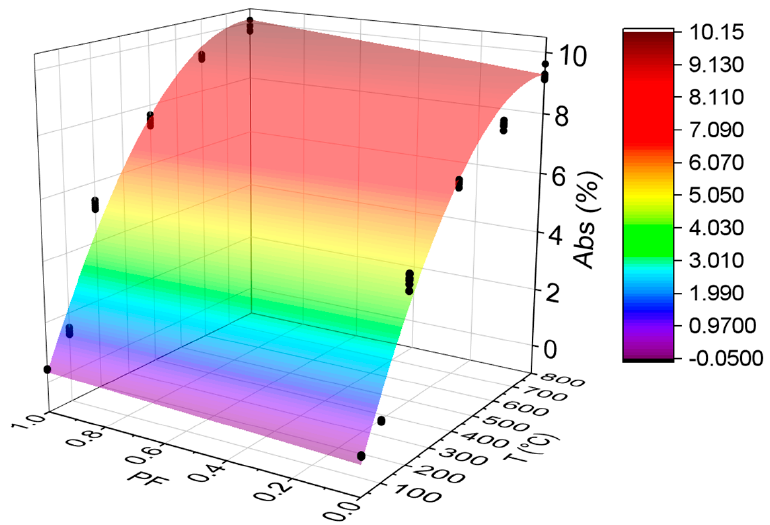
Figure 13. Quadratic multiple regression model fitting for absorption estimation.